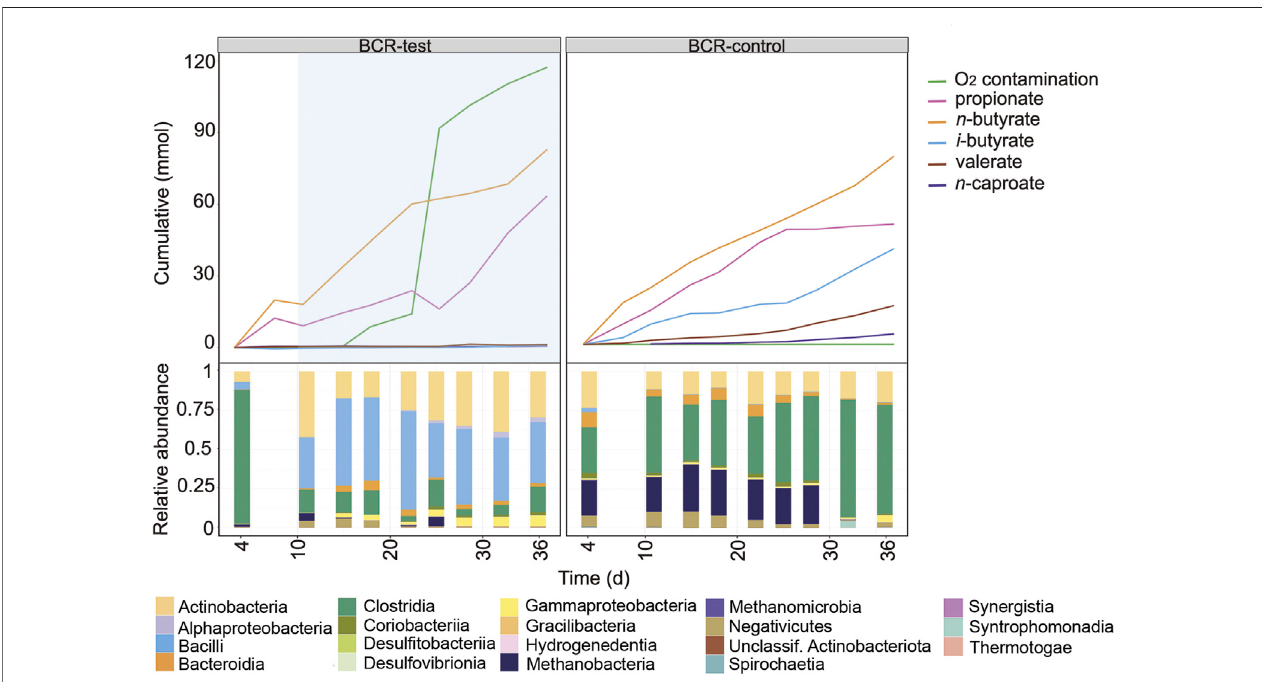
FIGURE 4 | Pro fi les of the cumulated amounts of carboxylates and O 2 , as well as community composition at class level between days 4 and 36 for BCR-test and BCR-control. Blue shading indicates the O 2 contamination period. Between days 11and 28, O 2 concentrations in the gasphase were detected up to18% in BCR-test, hence, determination of O 2 consumption in this time period might not be